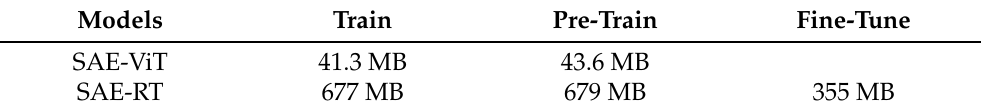
Table 3. The model sizes of our two different models on training, pre-training and fine-tuning.